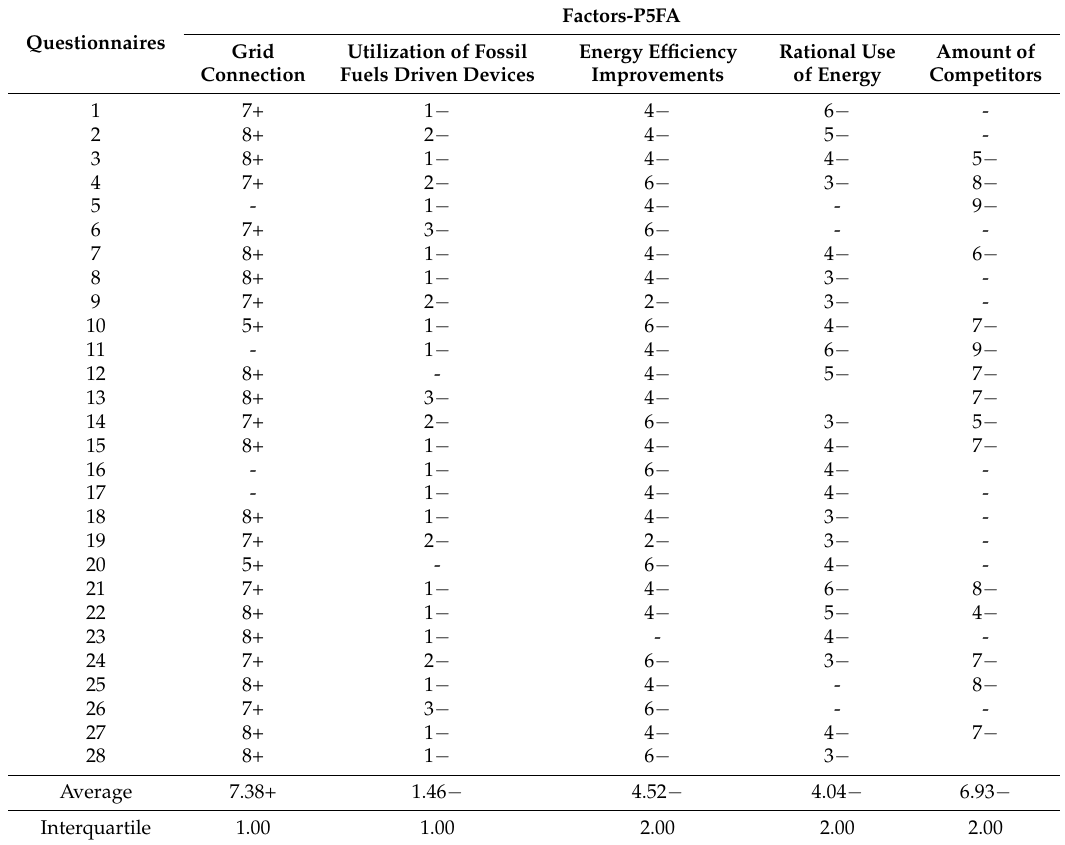
Table A2. Consistency check of the experts’ answers, Porters’ five forces analysis—interquartile range calculation (last line), empty cells (-) define no answers